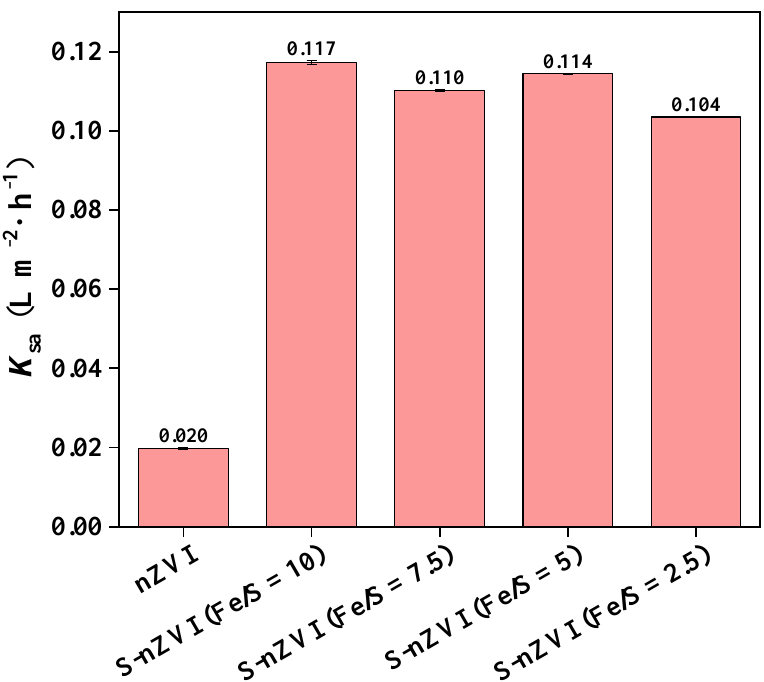
Figure 5. Reaction rates of TCE degradation by nZVI and S-nZVI materials with different Fe/S molar ratios. (pH: 7, t: 30 °C; nZVI and S-nZVI: 0.026 g, TCE: 10 ppm).